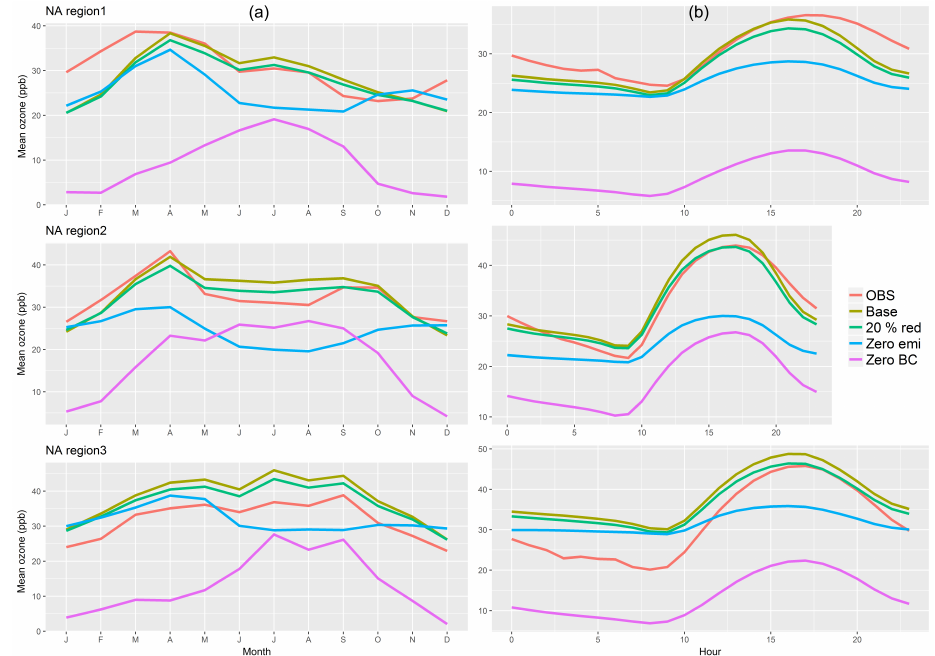
Figure 2. Average monthly (column a ) and diurnal curves (column b ) constructed from the January–December 2010 time series of hourly ozone observations and model simulations for three North American